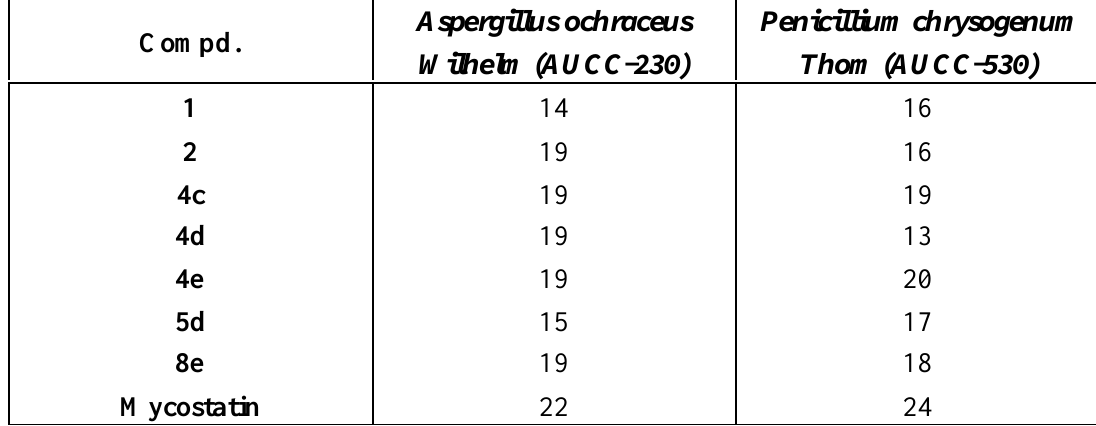
Table II: Antifungal activity of some compounds